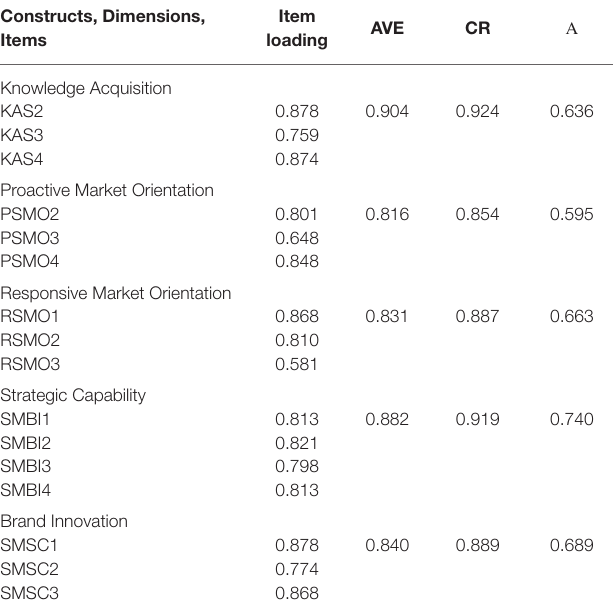
TABLE 1 | Measurement statistics of constructs. Constructs, Dimensions, Items